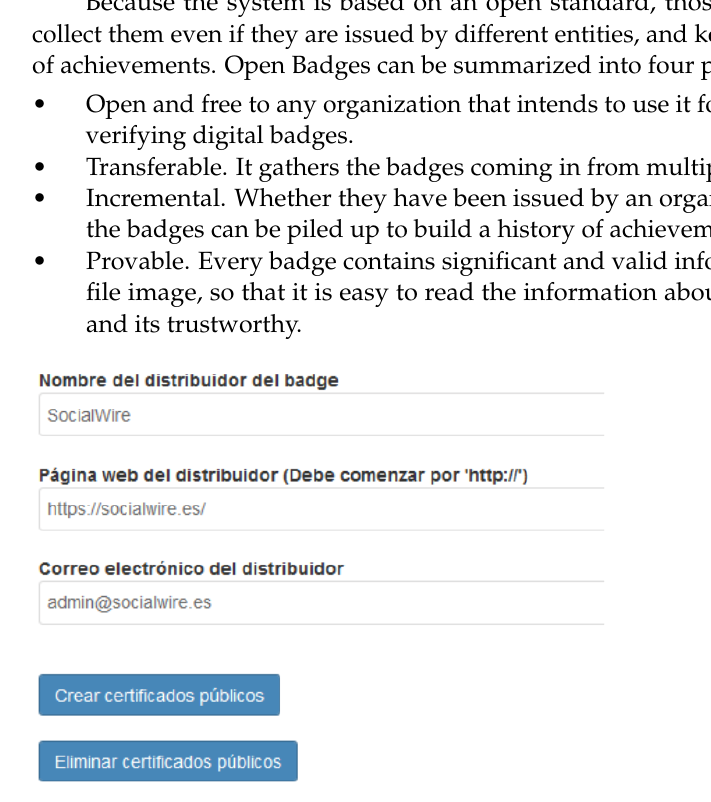
Figure A1. Generation of certificates that are visible in